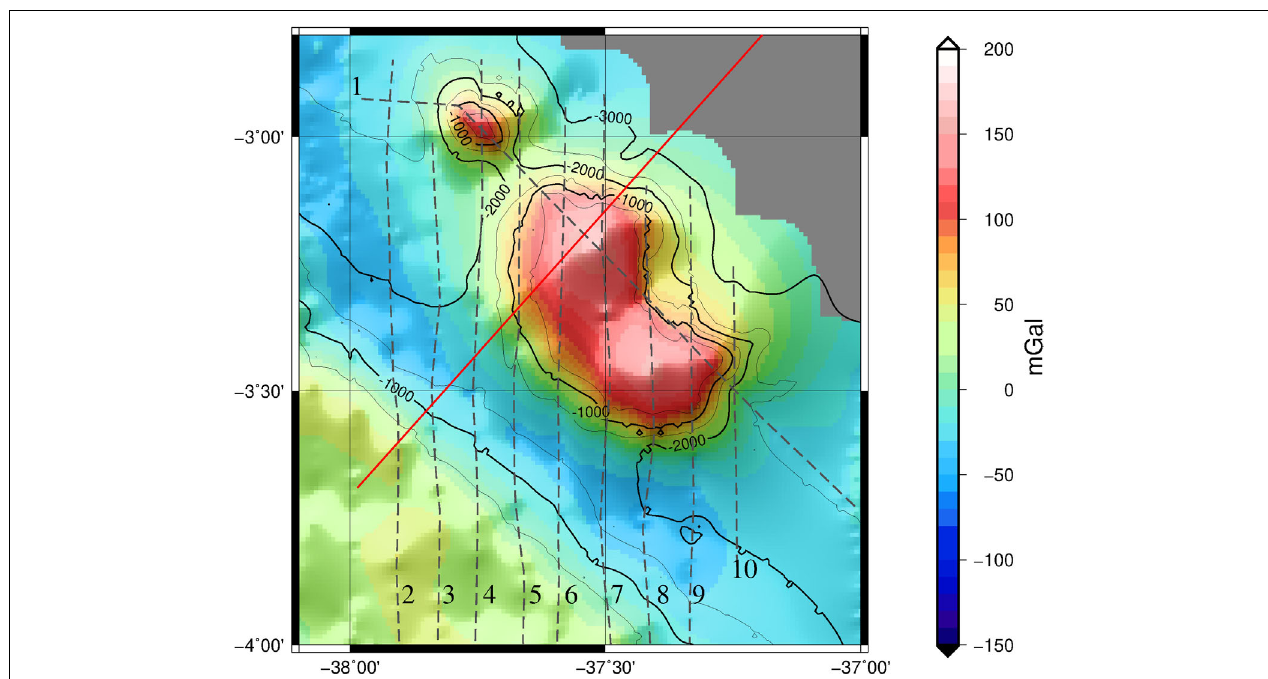
FIGURE 3 | Free-air gravity anomaly map and the location of the data in the study area. Dashed profiles #1 to #10 shows the position of bathymetric, gravity and magnetic marine survey, the red line shows the position of the seismic profile of Figure 2 . Bathymetric contours shown at 500 m